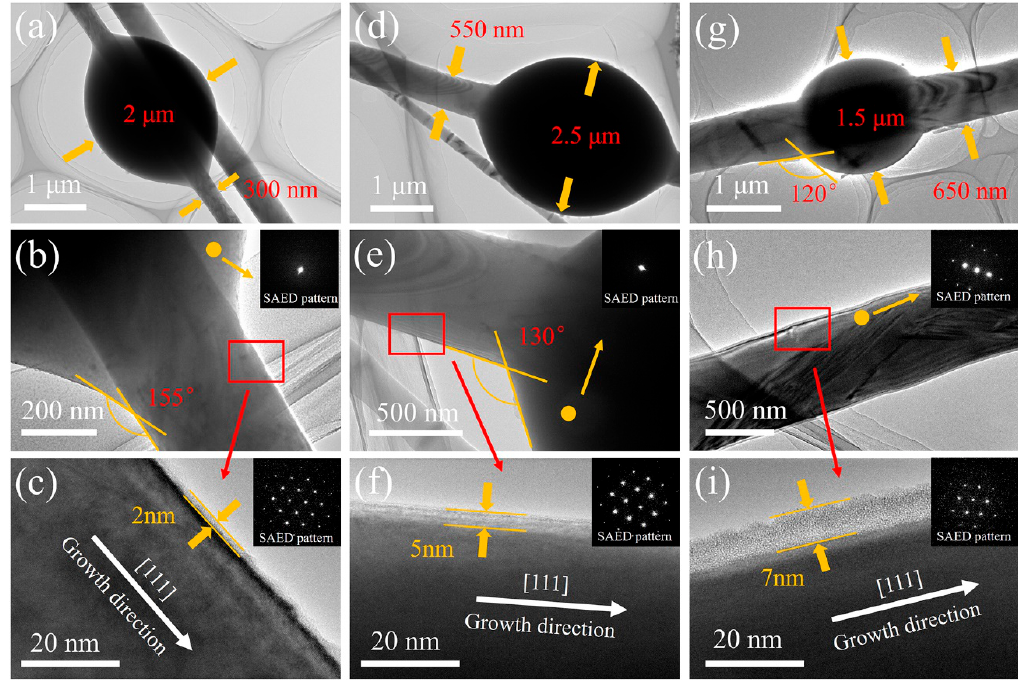
Figure7. Typical transmission electron microscopy (TEM) images, high-resolution